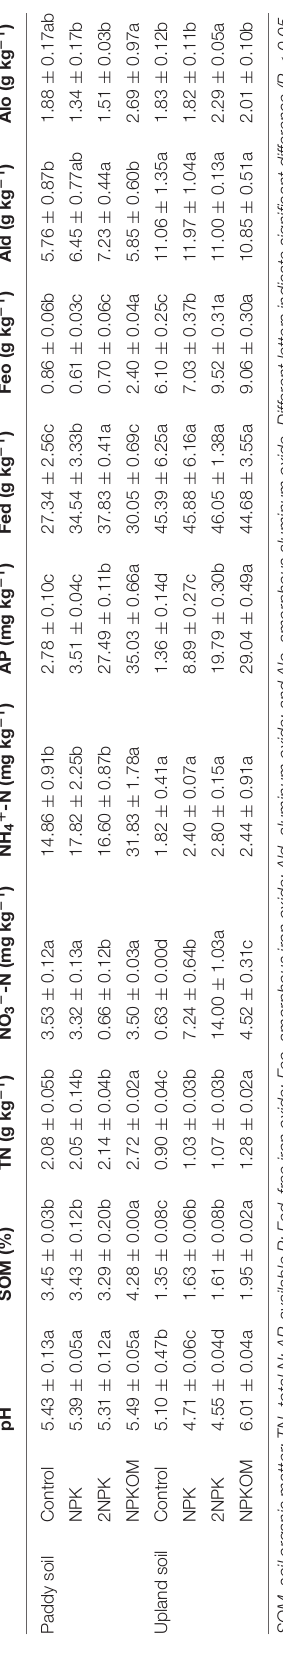
results for SDP ( Figure 1 ). Compared with the control, NPKOM and upland soils ( Figures 2A–C ). In upland soil, NPK markedly nosZ compared with the control ( Figures 2C,D ). The